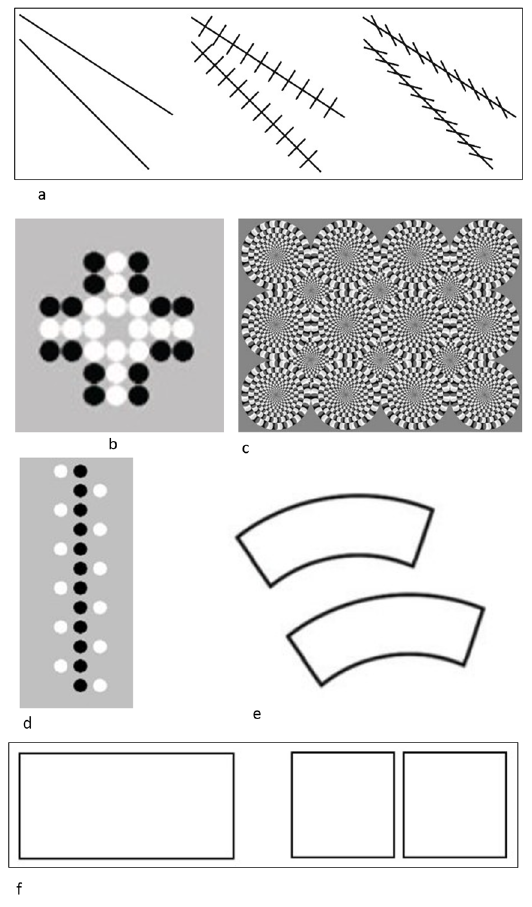
Figure 1. The illusions presented to monkeys, including the ( a ) Zöllner illusion with control stimuli at left, non-illusory cross-hatched stimuli at center, and the illusory image at right; ( b ) Solitaire illusion in which centrally located white dots are overestimated relative to an equal number of black dots on the perimeter; ( c ) Rotating Snake Illusion in which the static circular patterns appear to rotate; ( d ) density bias illusion in which the central, contiguous array of black dots appears more numerous than an equal number of white dots on the periphery; ( e ) Jastrow illusion in which the lower stimulus is typically reported to look longer than the upper stimulus; ( f ) one-is-more illusion in which the continuous stimuli at left appears larger than its partner discrete stimulus at right.